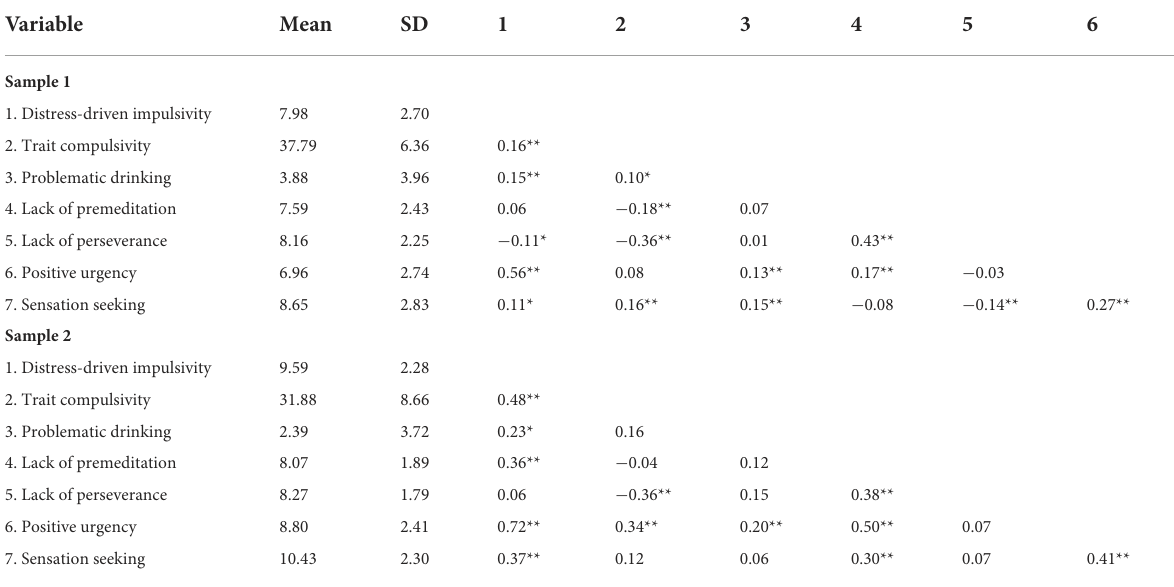
TABLE 2 Spearman’s correlation across study variables. Variable